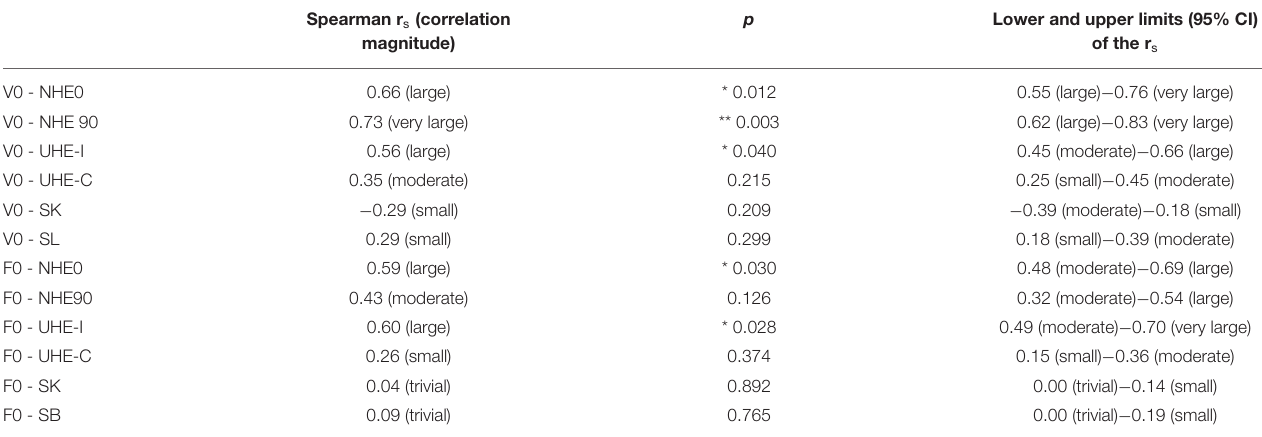
TABLE 3 | Results of correlation analysis between horizontal force production during sprinting and hamstring muscles performance at exercises. Spearman r s (correlation